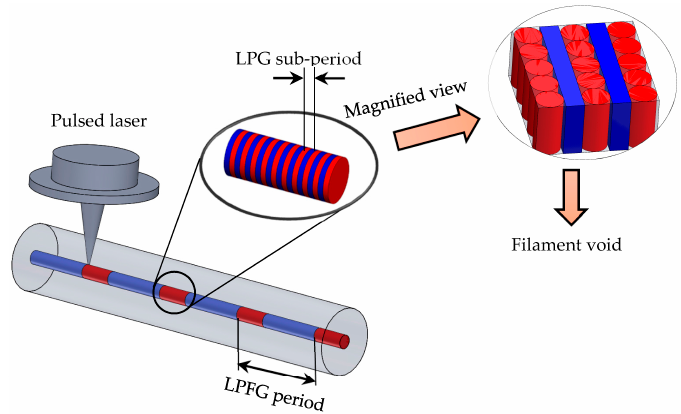
Figure 1. Schematic illustration of long-period grating fabrication.